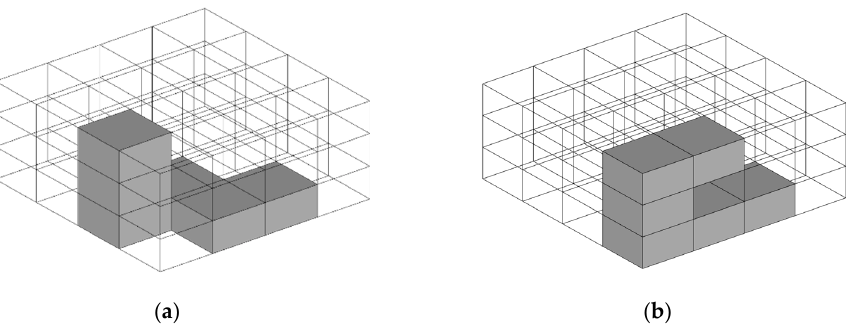
Figure 7. Batch violating rule 5, ‘towers’ are not allowed ( a ); an accepted configuration ( b ). Rule 6 : buildings with a height of three blocks should not be longer than three blocks